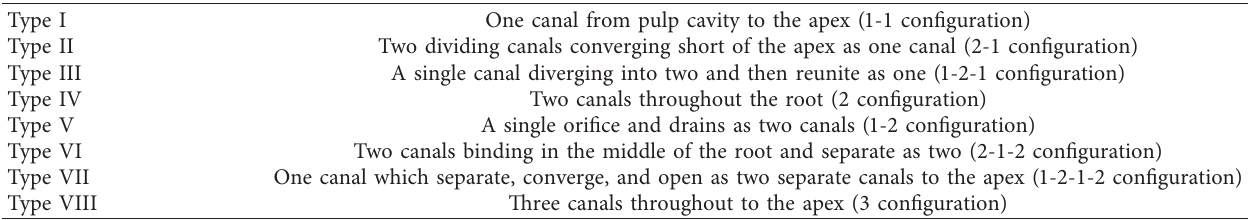
Table 1: Vertucci’s classification [7].